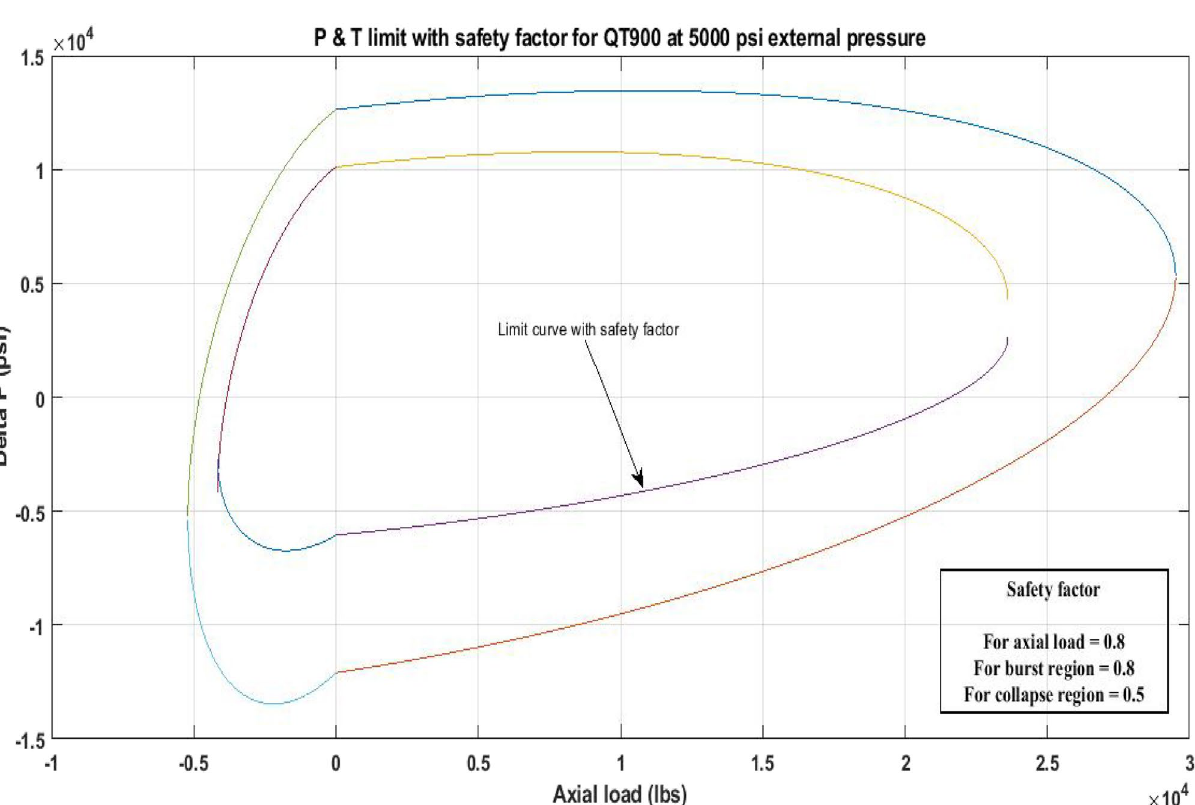
Figure 21. P and T limit with safety factor for QT 900 at 5000 psi P o